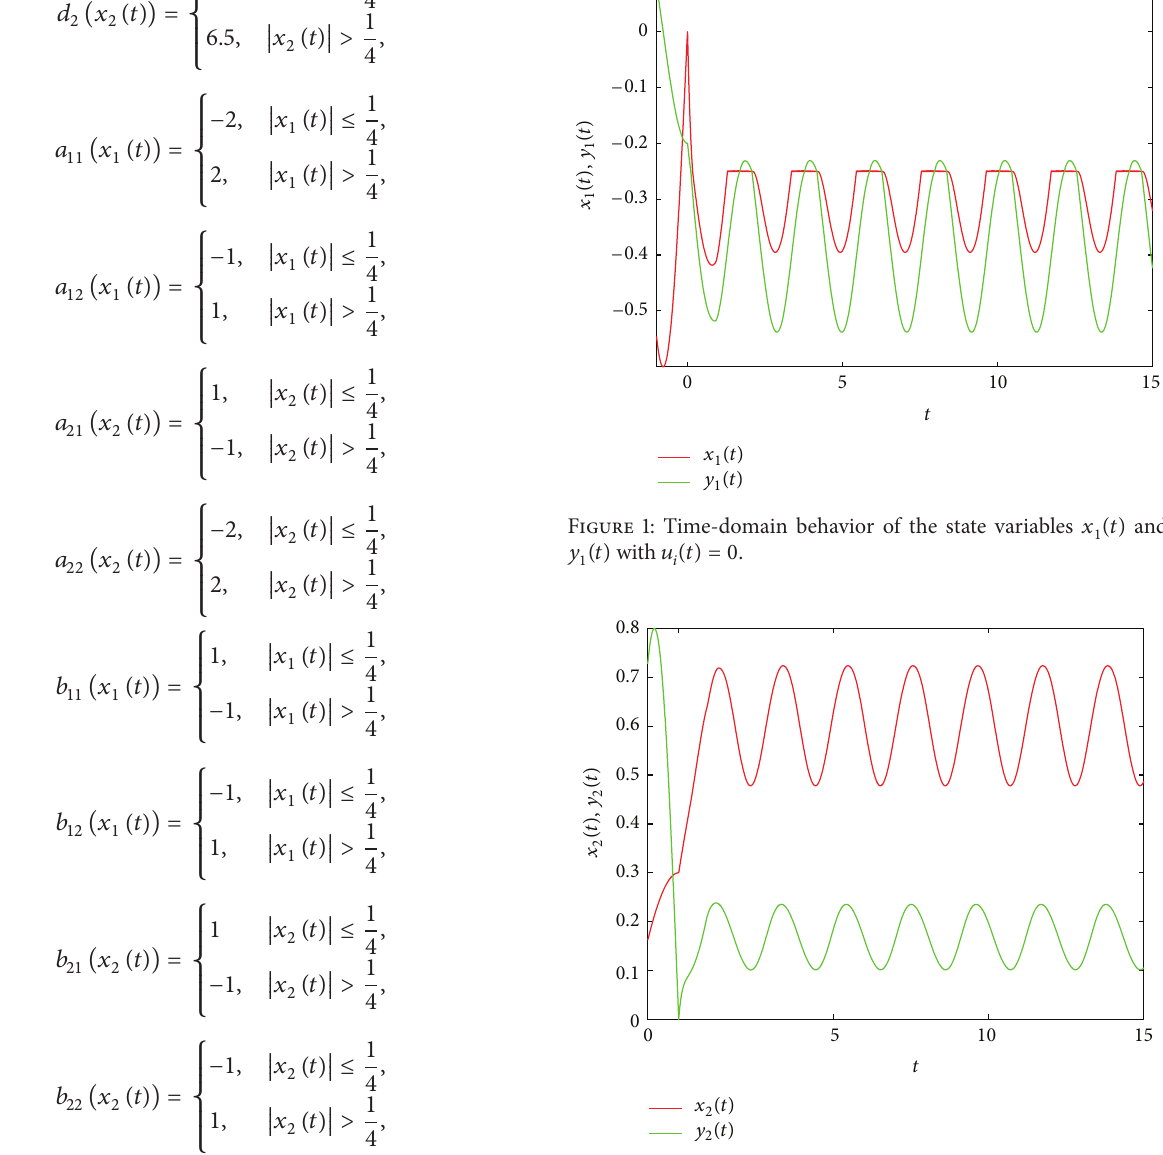
Figure 2: Time-domain behavior of the state variables 𝑥 2 (𝑡) and (𝑡) with 𝑢 (𝑡) = 0 𝑦 2 𝑖